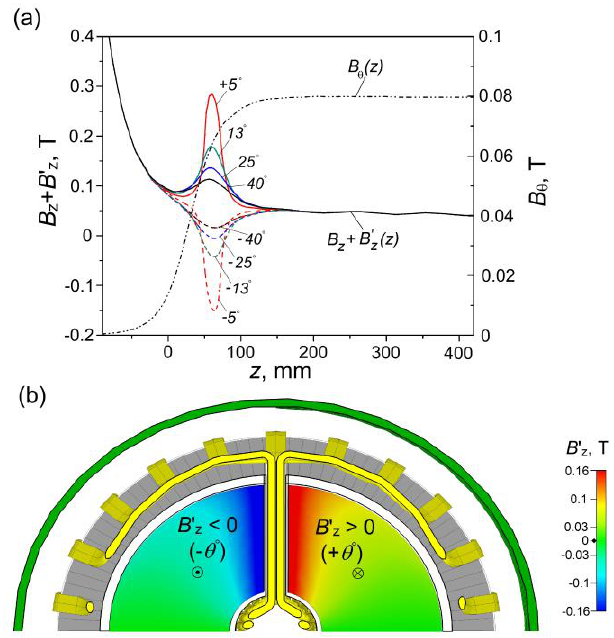
Fig. 3. (a) Distribution of magnetic field components in the collector along a typical electron trajectory at different azi muthal angle from the “wisp” . Local inhomogeneity of the axial magnetic field B z + B ' z on the “increasing” side ( +  – solid lines) and the “decreasing” side ( -  – dashed lines) are presented. (b) Distribution of the axial magnetic field B ' z  in the cross-section of the solenoid